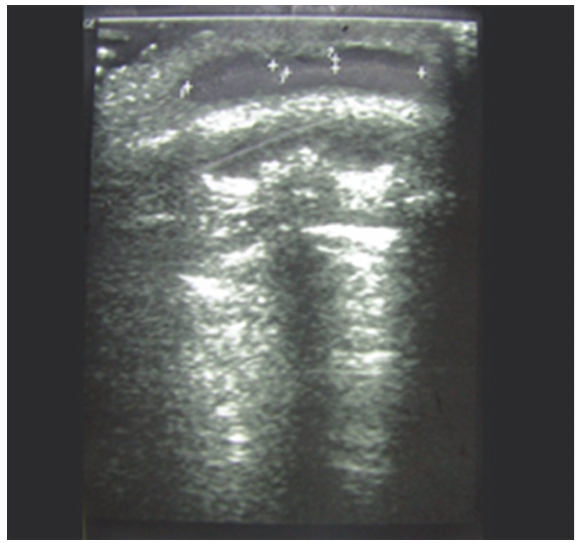
Figure 1: Sonogram of patient shows hypoecho subcutaneous